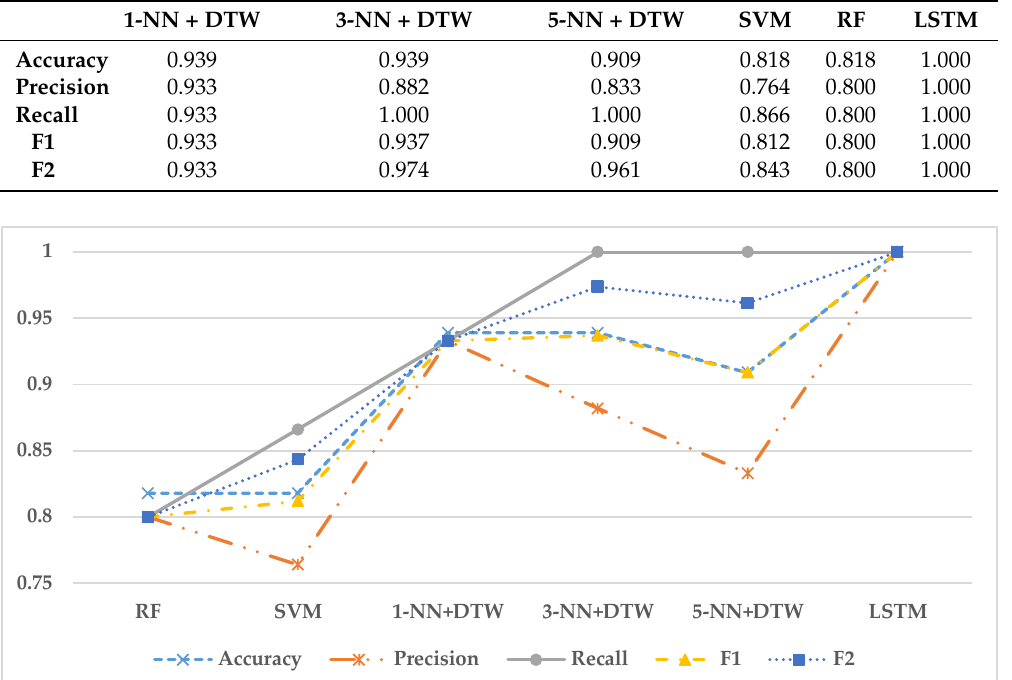
Table 2. Performance evaluation of six models.